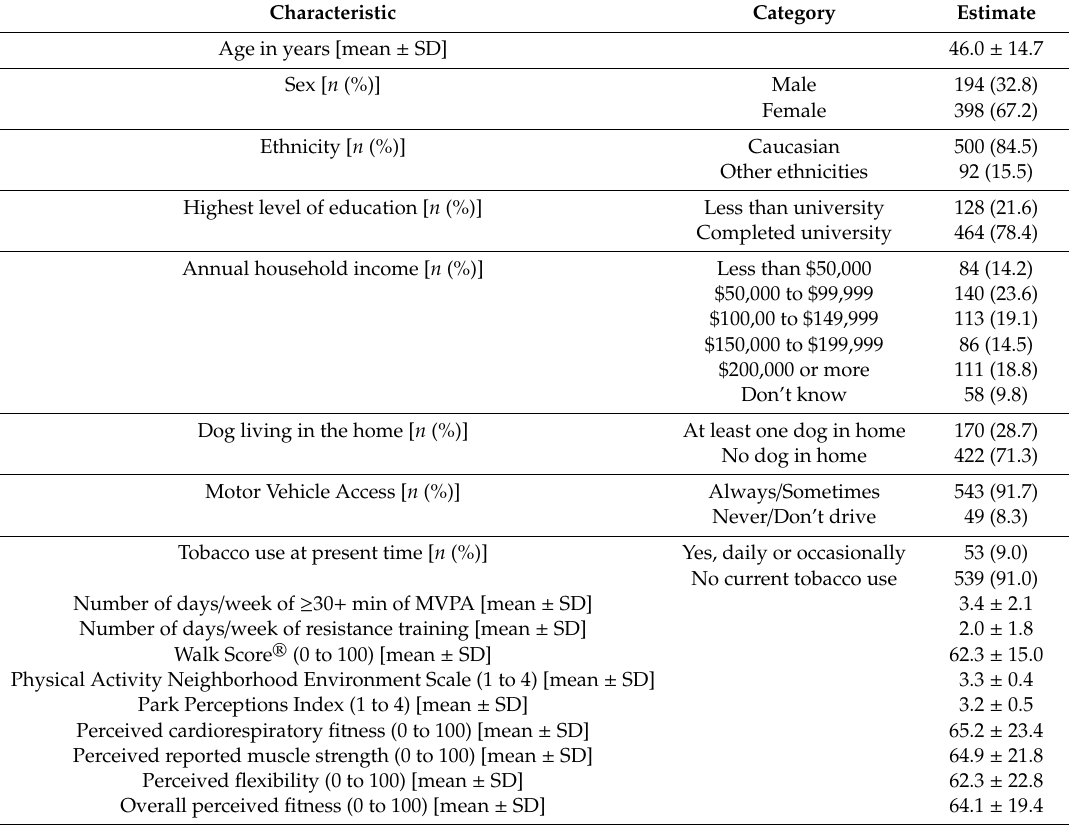
Table 1. Sample profile of sociodemographic, physical activity, built environment, and fitness variables ( n =